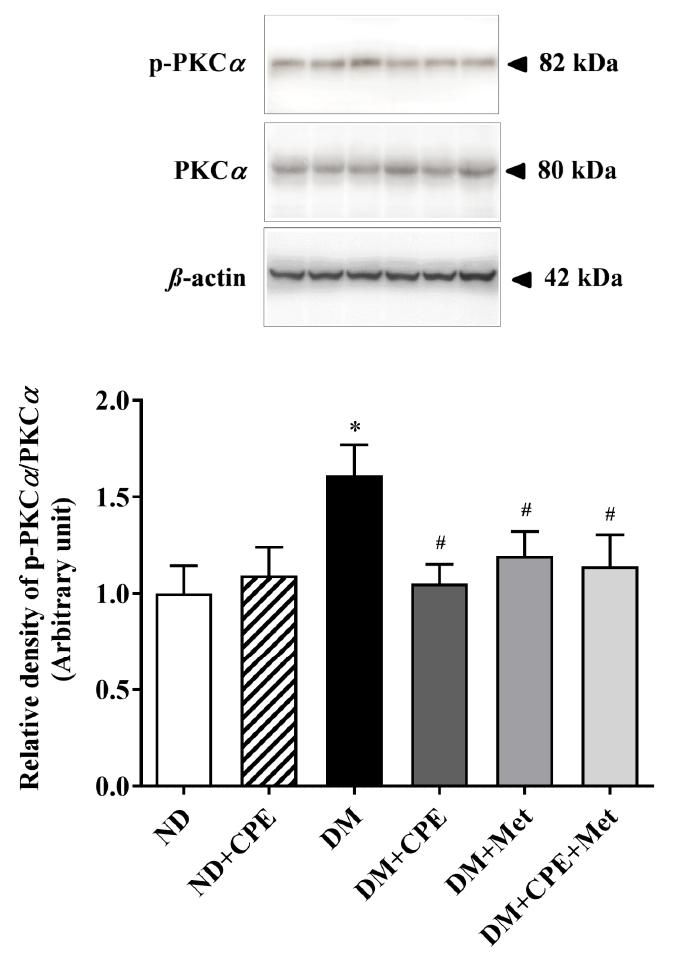
Figure 5. Effect of CPE on PKC α expression and activation, which is determined by p-PKC α /PKC α ratio in T2D rat kidney cell lysate. Anti-p-PKC α and PKC α antibodies were detected at 82 and 80 kDa, respectively, whereas anti- β -actin antibody was used as a loading control. Densitometry was analyzed and expressed as mean ± S.E.M., and the experiment was repeated in animals ( n = 4–5). * p < 0.05, significantly different from ND; # p < 0.05, significantly different from